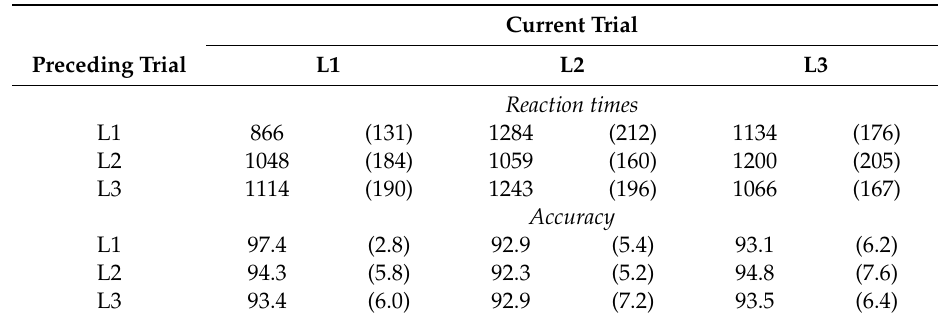
Table 3. Reaction times (in ms) and accuracy (in percent) for the picture-naming task, by language of preceding and current